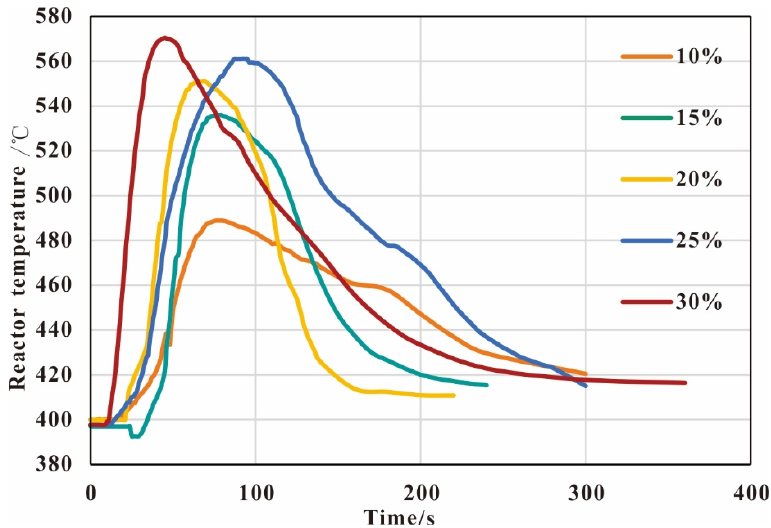
Figure 7. Temperature changes in the reactor during the supercritical water–diesel reaction experi- ment under different oil–water ratios.